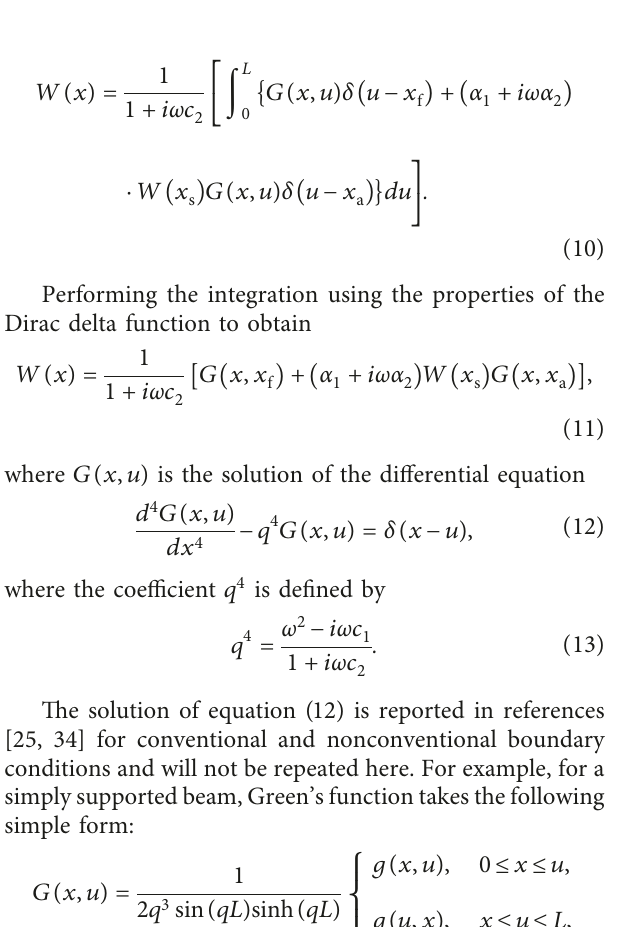
Figure 1: Configuration of a harmonically excited cantilever beam with vibration control